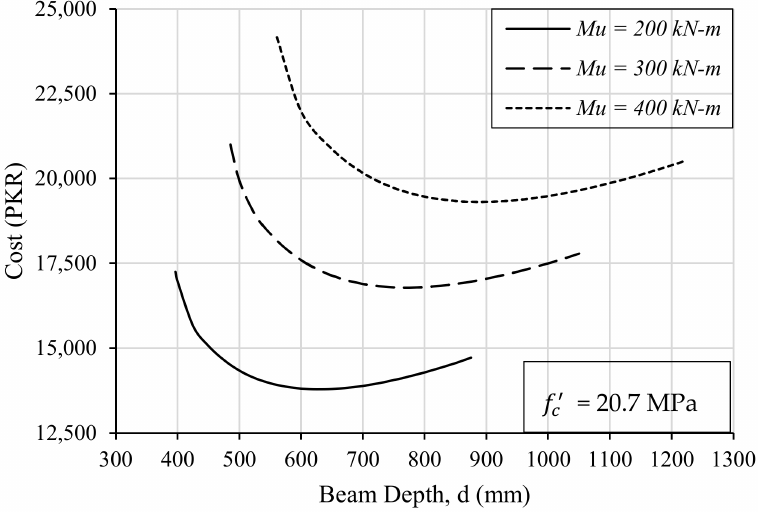
Figure 2. The relationship between the depth of the beam and the cost of construction.